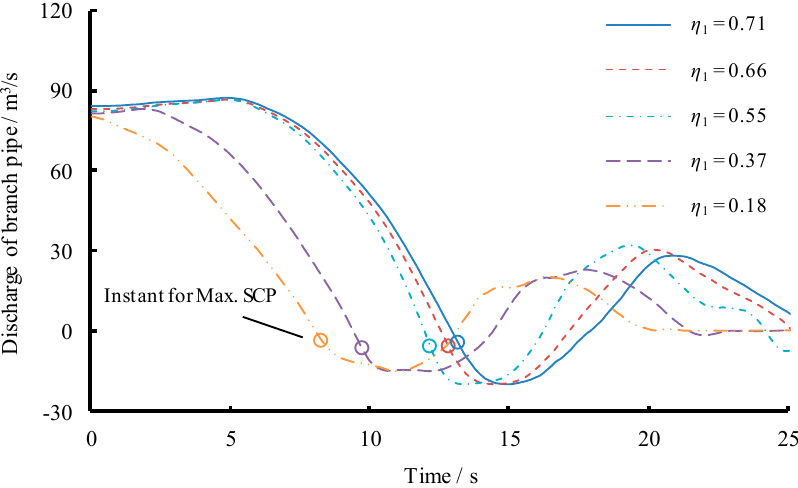
Figure 11. Main pipe discharge of different η 1 versus time for Scenario 1.